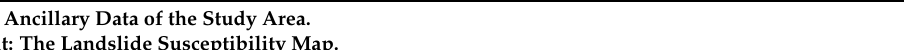
Table 2. Procedures of the GWR-PSO-SVM algorithm.